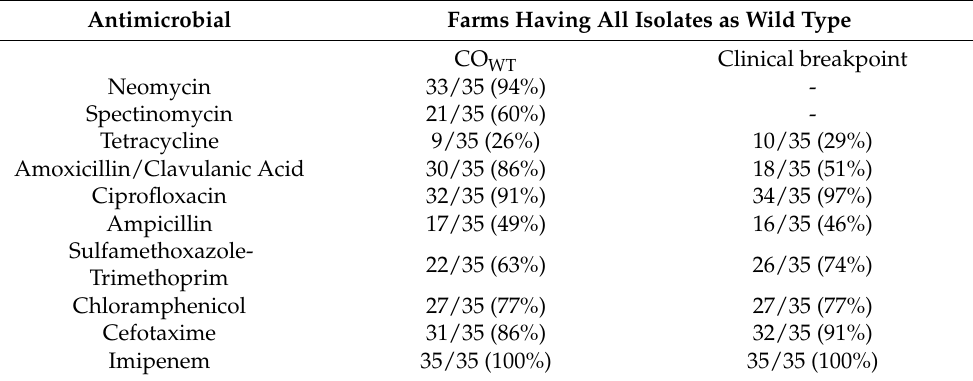
Table 5. Farm-level prevalence of antimicrobial susceptibility of all E. coli isolated from sheep and beef farms based on the NRI method (CO WT ) and clinical breakpoints. Antimicrobial Farms Having All Isolates as Wild Type CO WT Clinical breakpoint Neomycin